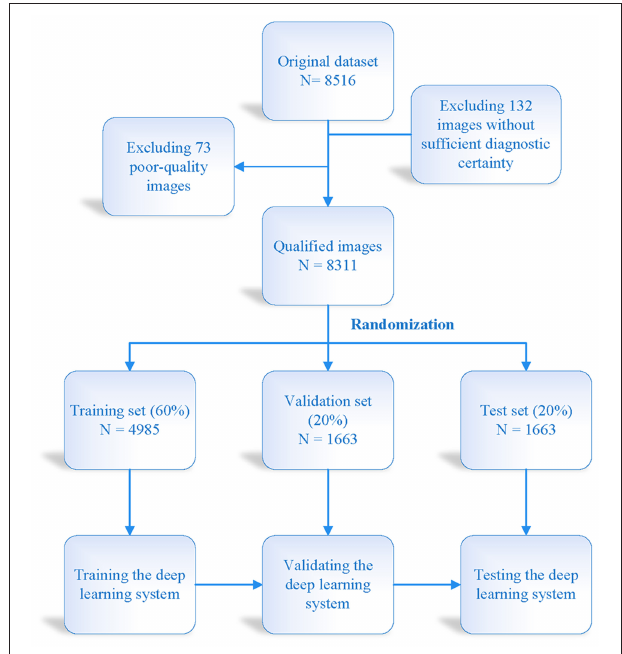
FIGURE 2 | Flow chart illustrating development of the deep learning